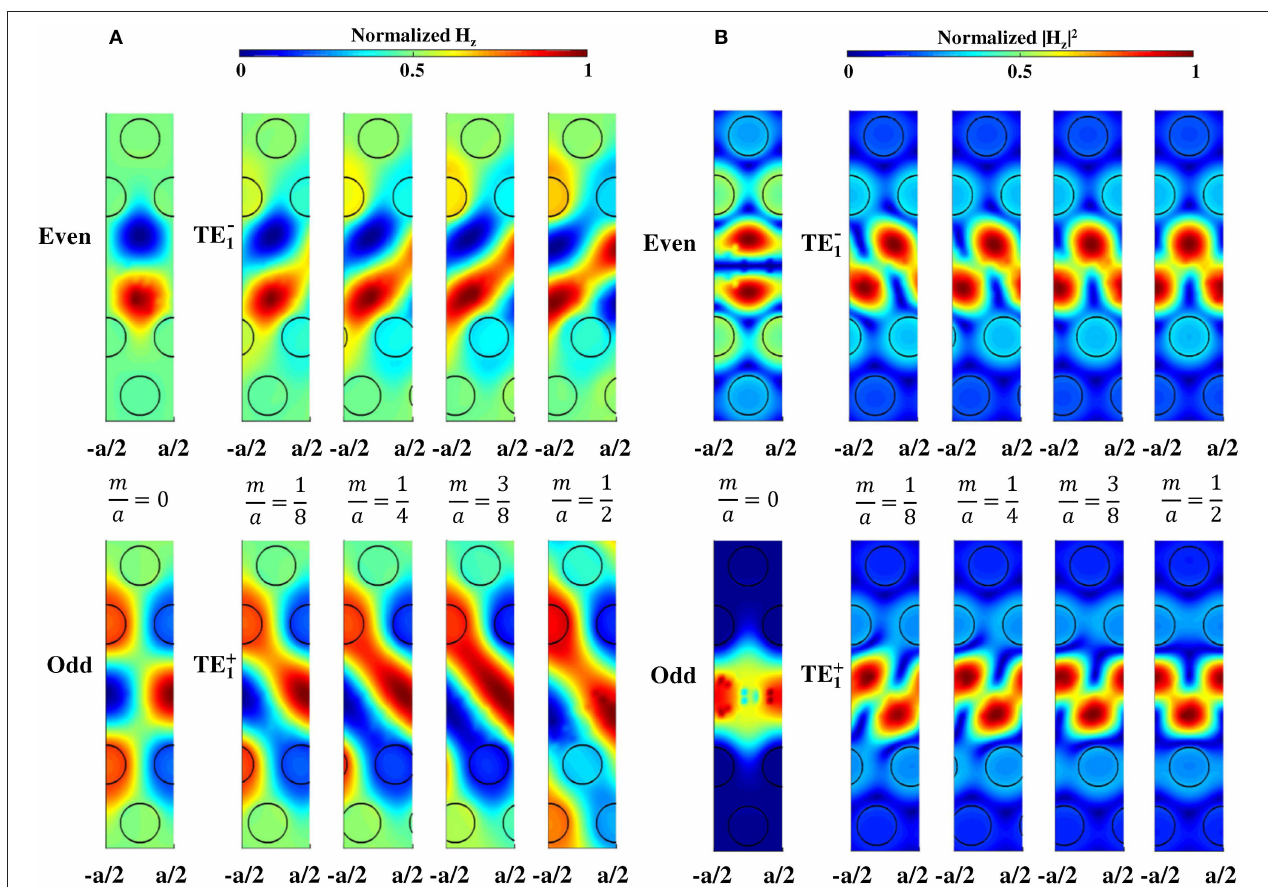
π/ a of the BZ end. =